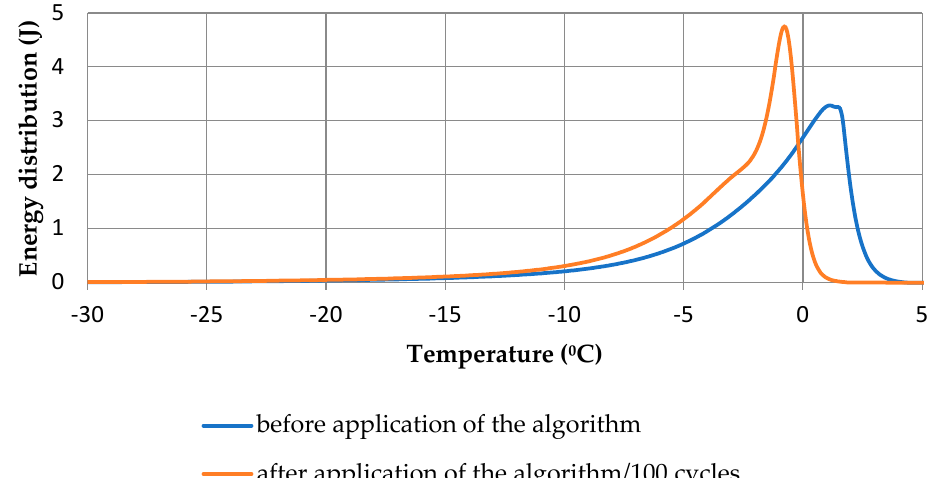
Figure 12. Distribution of phase transition energy of the CEMII / B-V cement mortar, w / c = 0.53. Assigning the recorded signals to lower temperatures caused the corresponding amounts of energy to be divided by the lower value of the latent heat, and, thus, the calculations gave a higher total mass of ice. On basis of the initial energy distribution, the mass of ice equaled 1.08 g and increased to 1.09 g after the application of the algorithm.